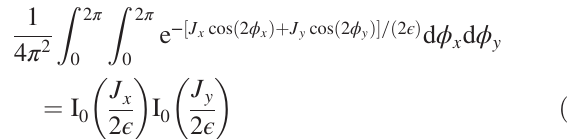
FIG. 2. Simulated luminosity, bunch population and transverse rms emittances for physics fills in HL-LHC, HE-LHC and FCC- hh including synchrotron radiation damping and intra-beam